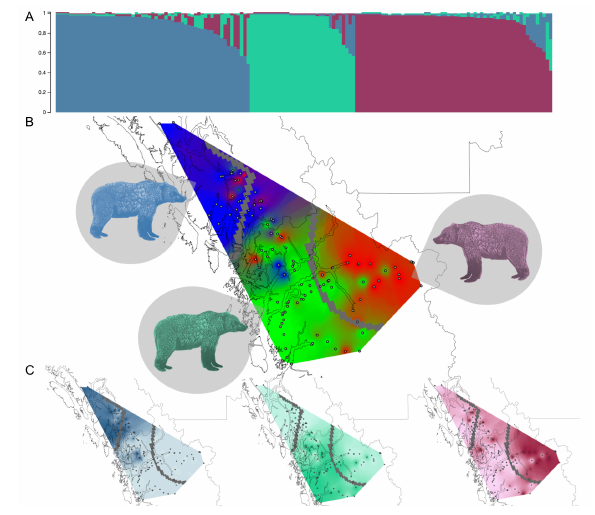
Fig. 2. Plots of grizzly bear genetic and Indigenous language family overlap. Plots are STRUCTURE bar plot at K = 3 (A) and combined (B) and separate (C) inverse distance weighting- interpolated STRUCTURE population Q -value maps (blue = G1, green = G2, red = G3). Dark grey lines indicate borders among Indigenous language families (approximate overlap: blue = Tsimshian, green = Wakashan, red = Salishan Nuxalk); light grey points indicate mean detection locations of individual grizzly bears.